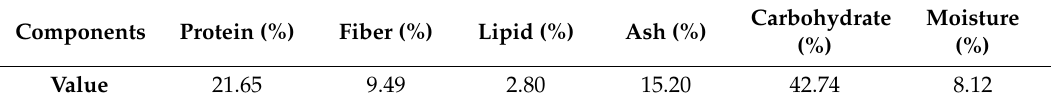
Table 2. The nutrient composition of Vitex agnus-castus